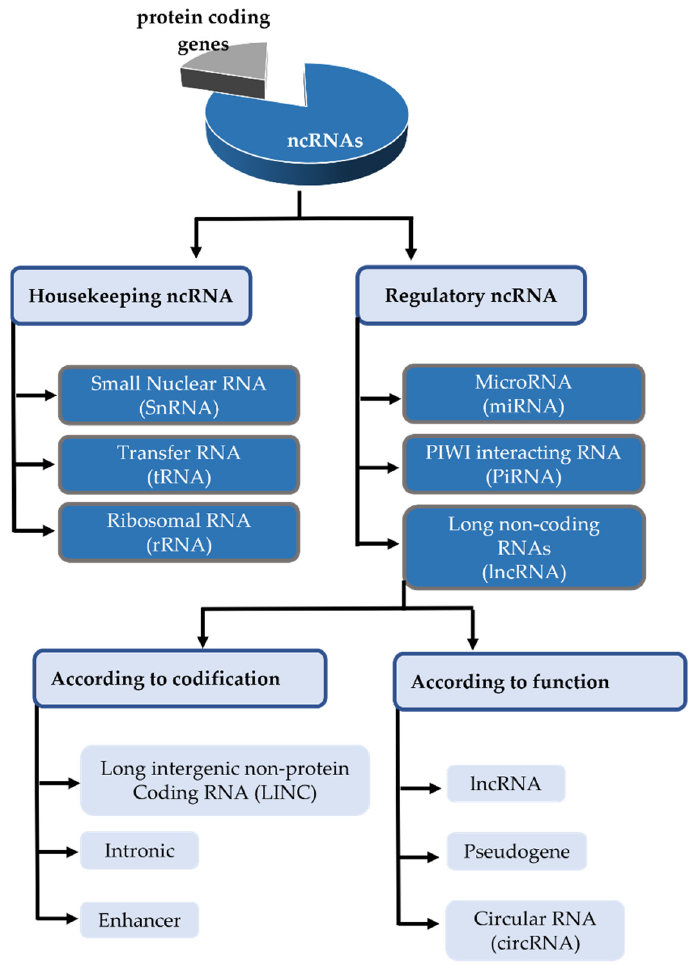
Figure 4 . Classification of the non-coding transcriptome. Figure 4. Classification of the non-coding